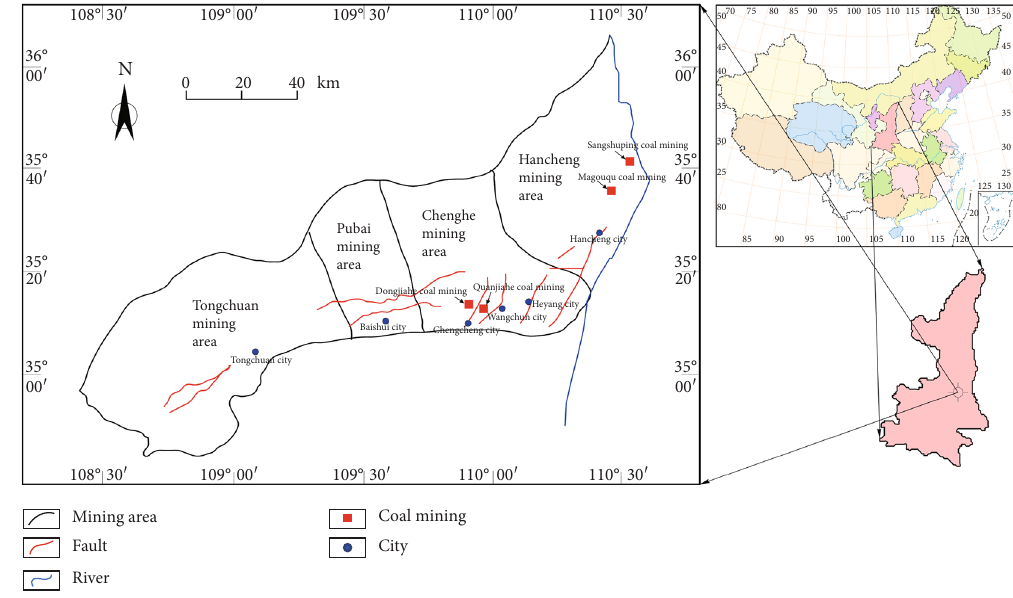
Figure 1: Boundary of research